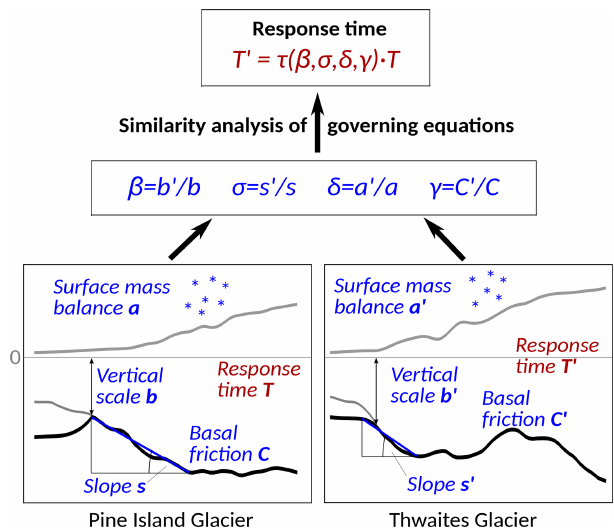
Figure 1. Schematic visualizing the presented approach to obtain the response-time ratio τ between different Antarctic outlets as a function of their specific physical properties, here exemplified for Pine Island Glacier (unprimed reference) and Thwaites Glacier (primed scales). Blue variables are obtained from observations and model data. The equations for τ (Eqs. 2 and 3) result from a simi- larity analysis of the stress balance and conservation of mass (Feld- mann and Levermann,